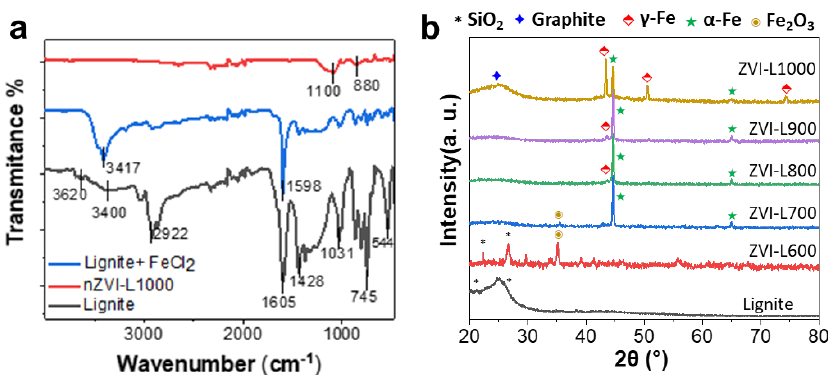
Figure 1. ( a ) Baseline-corrected FTIR spectra of lignite, FeCl 2 -impregnated lignite and ZVI-L1000; ( b ) XRD patterns for ZVI-LXs synthesized at 600 – 1000 vs. lignite.